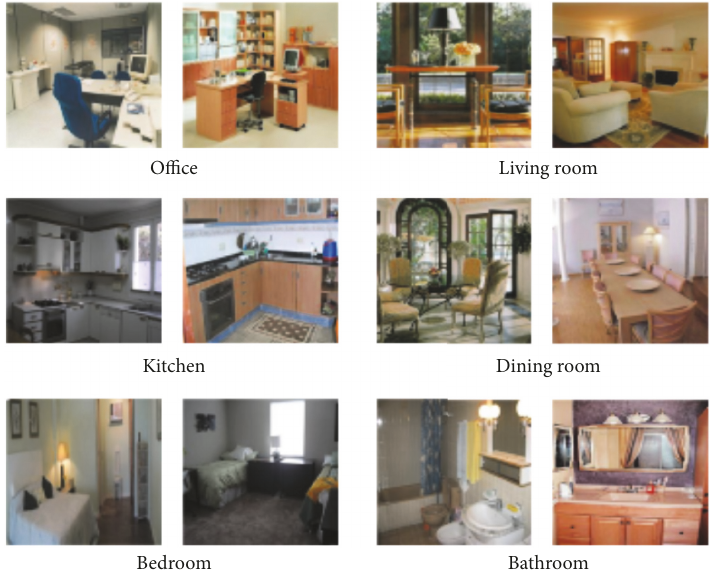
Figure 4: Some examples of indoor scene image in MIT 67